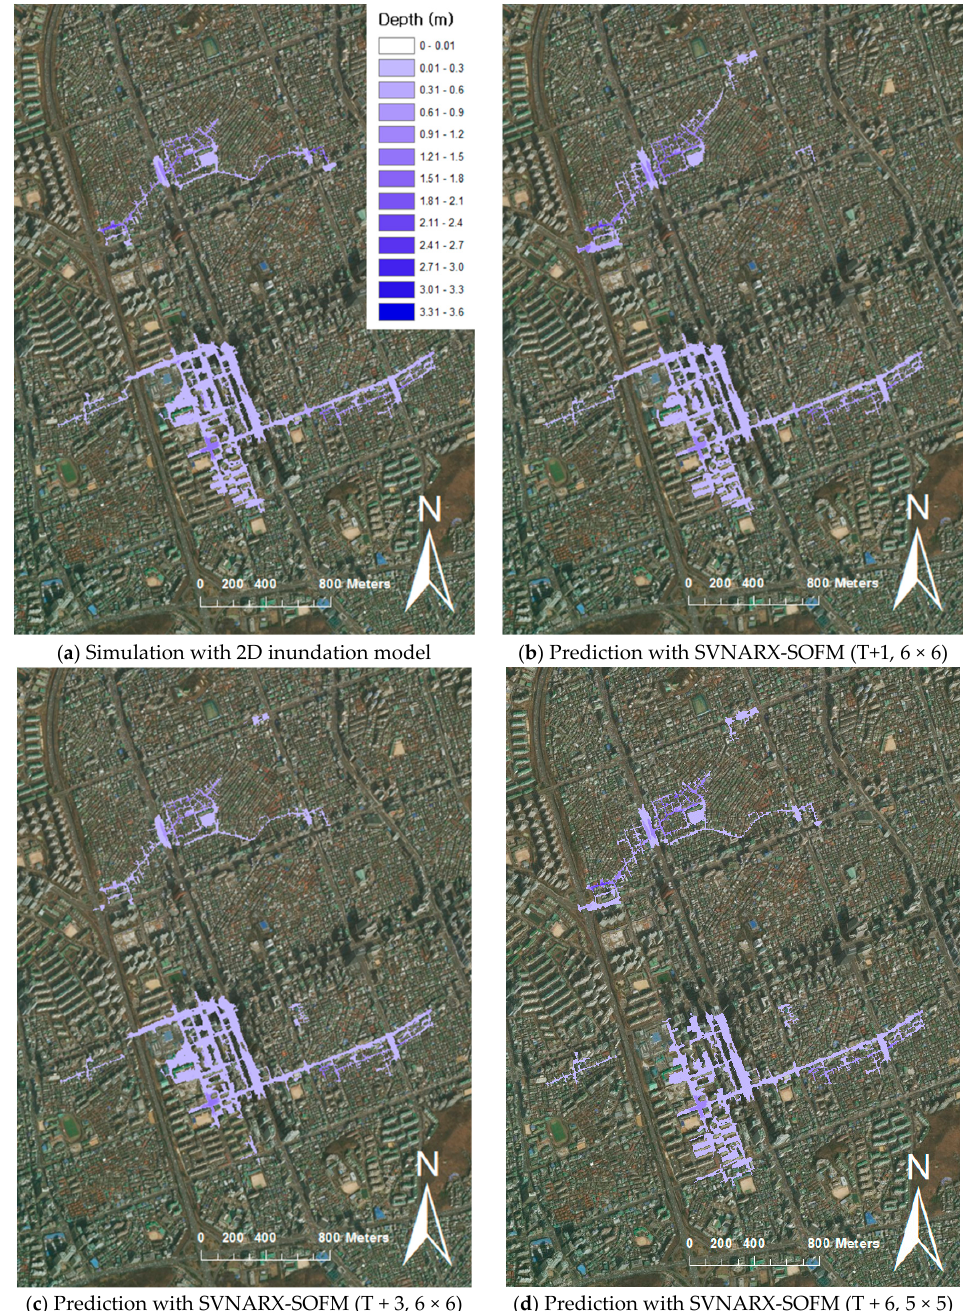
Figure 11. Simulated and predicted inundation map.